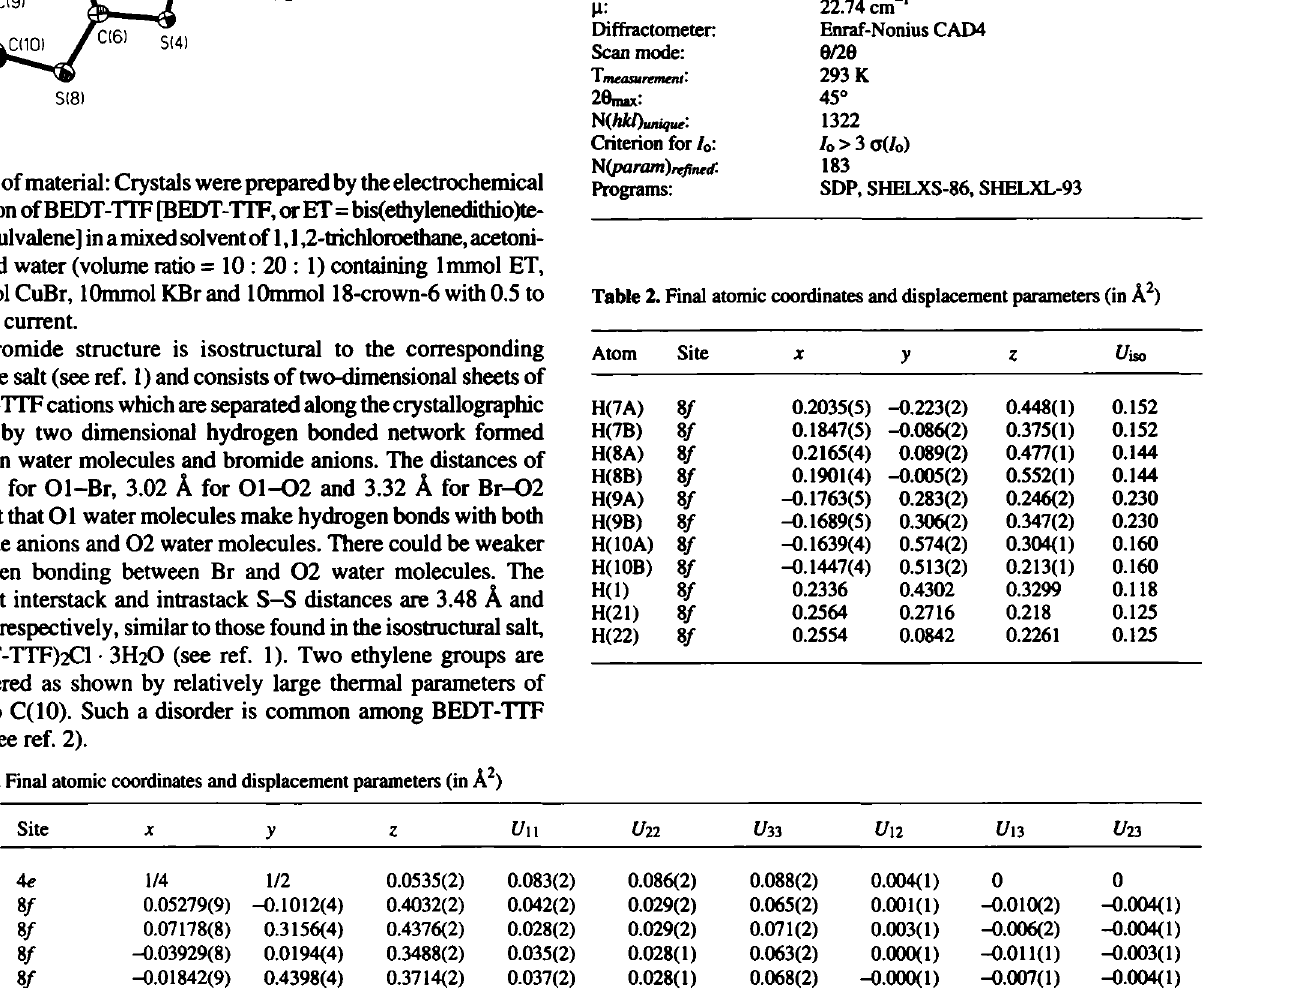
Table 1. Parameters used for the X-ray data collection